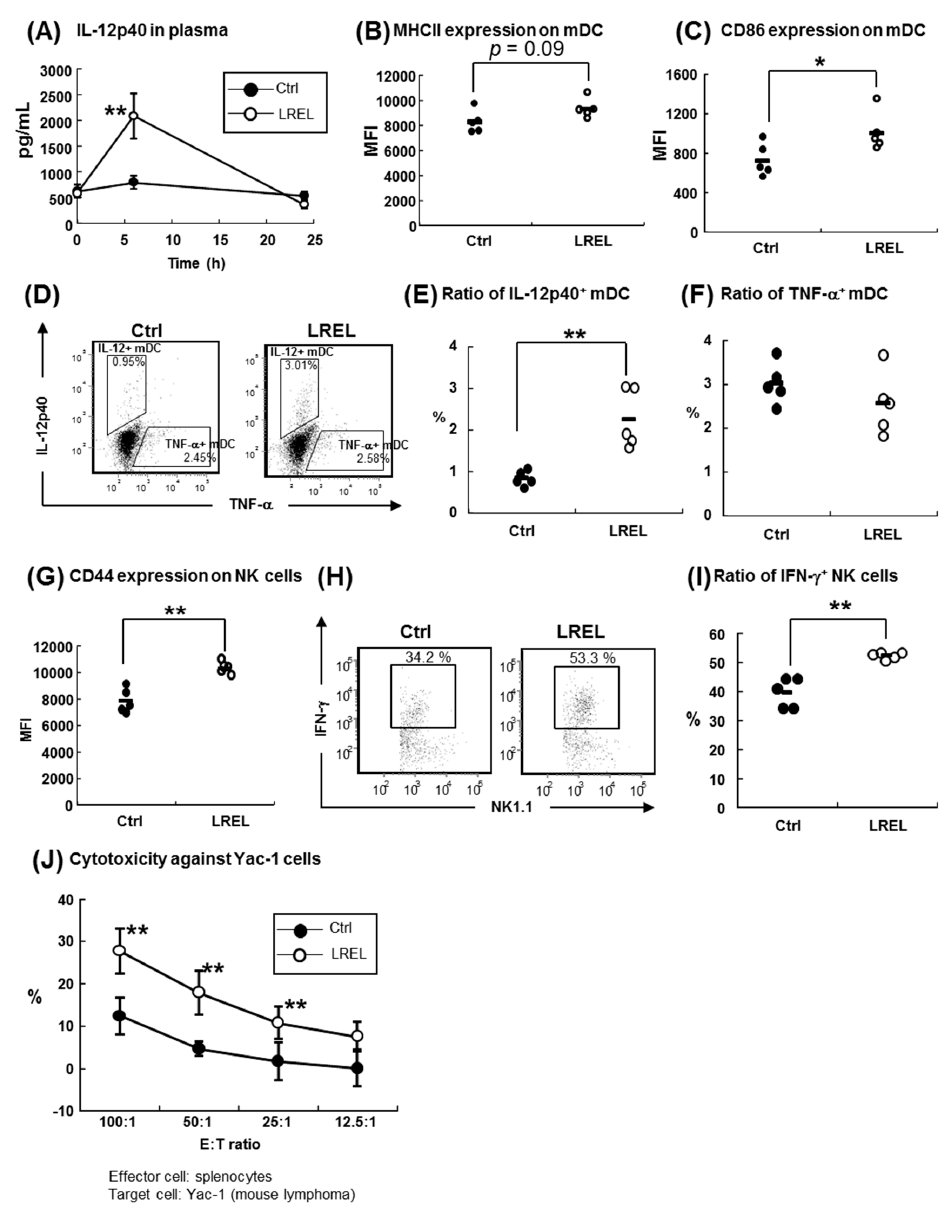
Figure 1. Splenic dendritic and NK cell activation by LREL i.p. treatment. Healthy C57BL/6J mice were divided into control or LREL groups ( n = 5 in each group). Mice in the LREL group were intraperitoneally administered 200 μ g of LREL dissolved in phosphate buffer saline (PBS). Mice in the control group were administered the same volume of PBS. All mice were sacrificed 24 h after treatment. ( A ) Sequential IL-12p40 concentrations in plasma. Data are shown as mean ± SD ( n = 5).